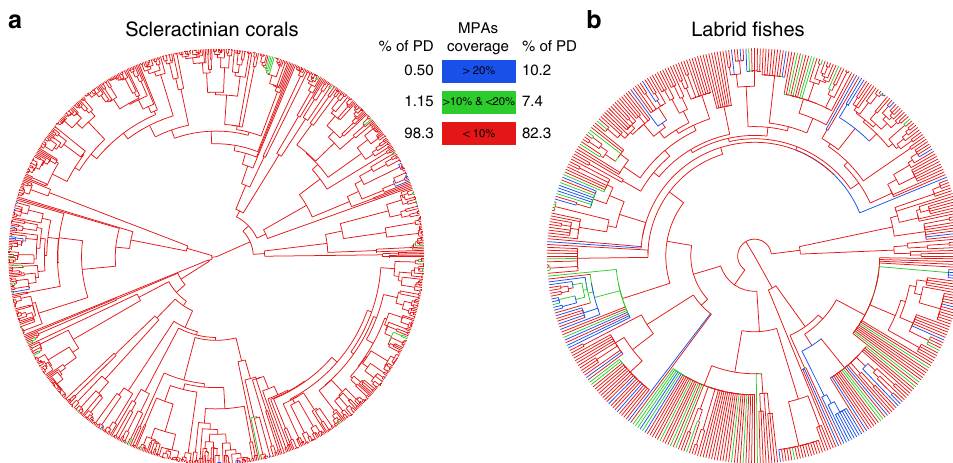
Figure 2 | Percentages of geographic ranges covered by the global system of MPAs for species and internal branches across the Tree of Life. ( a ) Scleractinian coral species and ( b ) fish species of the family Labridae. Species or branches in red do not meet the minimum 10% representation threshold, that is, o 10% of their geographic range is covered by MPAs, while green and blue colours indicate 10–20% and more than 20% coverage respectively. The corresponding percentage of total phylogenetic diversity (PD) is indicated for each coverage